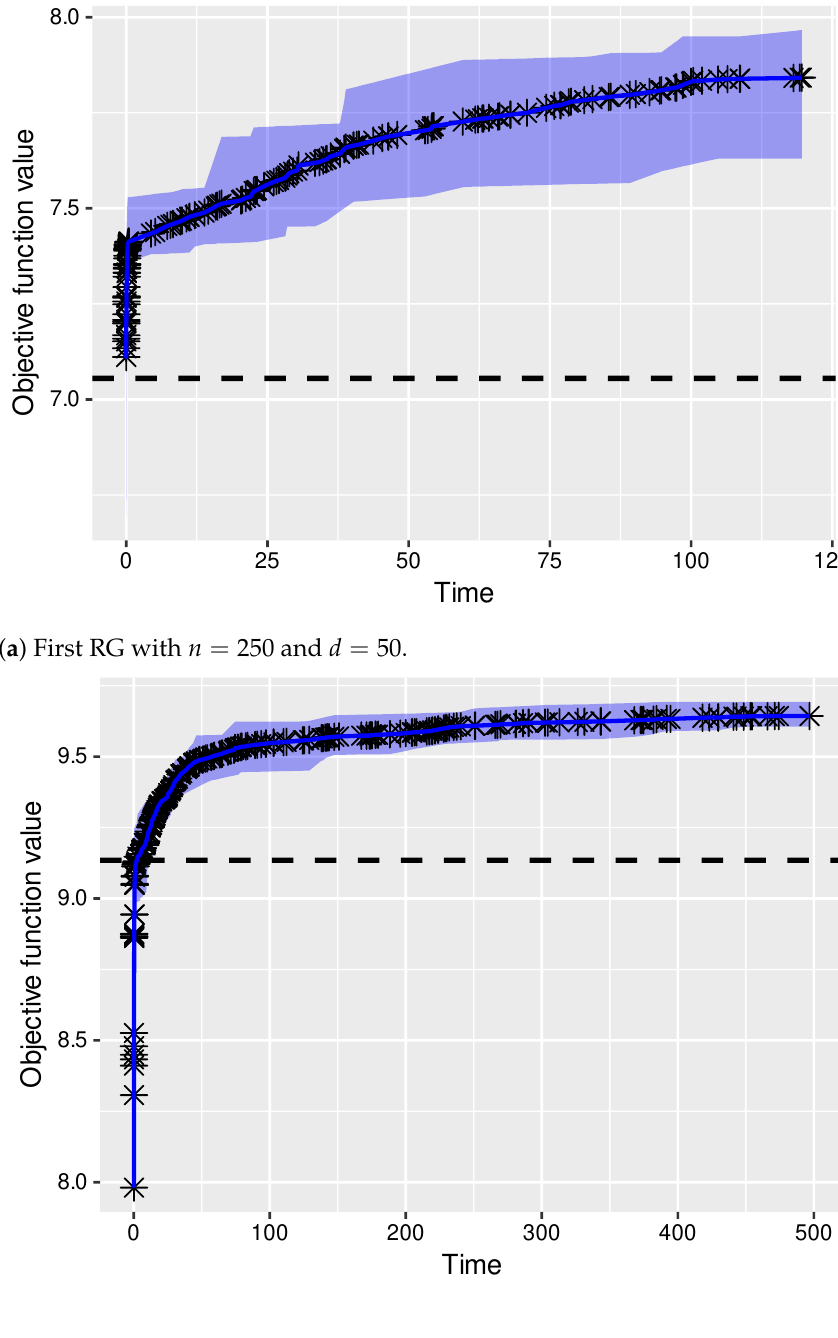
Figure 4. Evolution of the quality of the solutions produced by PBIG over time. Both graphics show the results of 10 independent PBIG